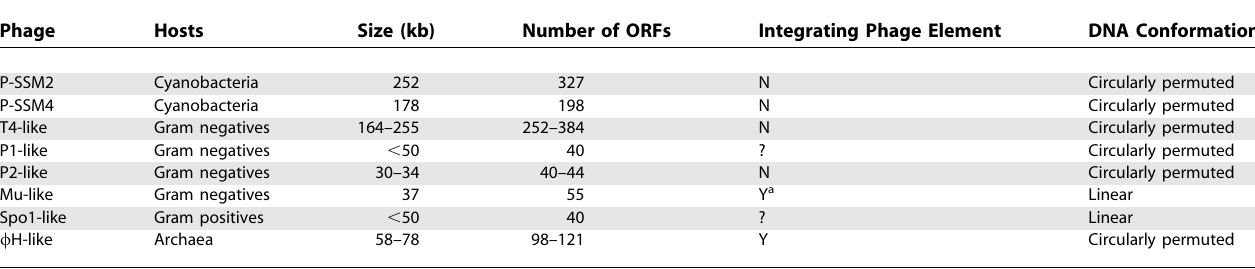
Table 3. Genome-Wide Characteristics of the Prochlorococcus Cyanomyophages P-SSM2 and P-SSM4 Relative to the Other Recognized Phage Groups within the Myoviridae [105]